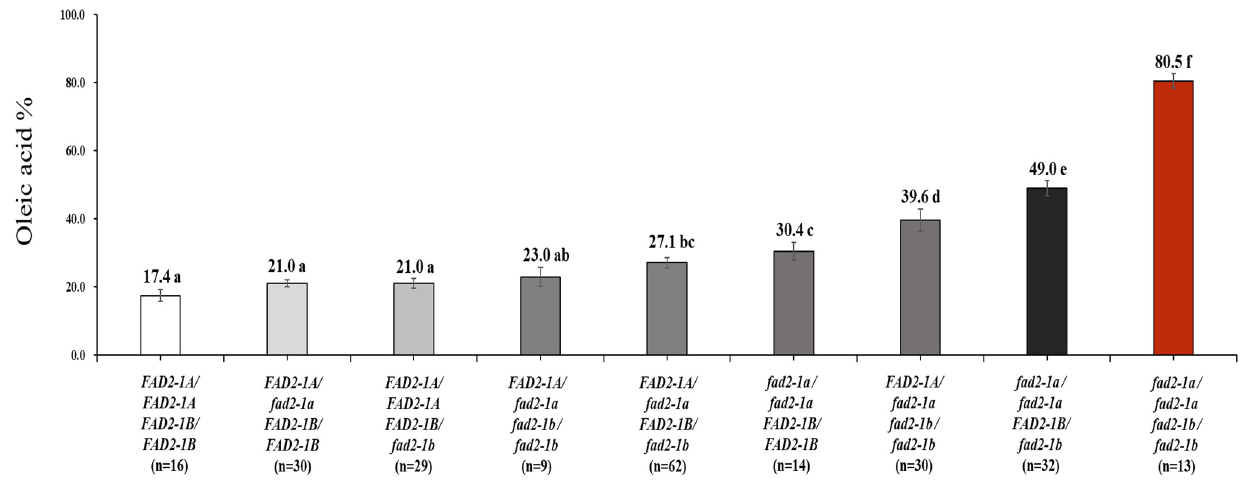
8 of 13 Figure 2. Distribution of oleic acid content from two segregating populations. ( a ) 100 F 2 seeds from a cross of PE529 and Pungsannamul showed altered oleic acid based on its genotype of FAD2-1A gene. ( b ) 100 F 2 seeds from a cross of PE529 and Sunpung showed altered oleic acid based on its genotype of FAD2-1A gene. The letters above the bars are statistically different based on least square difference. The FAD2-1A indicates functional microsomal delta-12 fatty acid desaturase 2 gene which is similar to the Williams 82 reference sequence for Glyma.10G278000 . The fad2-1a indicates mutant allele of FAD2-1A W293STOP in PE529. 3.4. Production of 80% Oleic Acid Concentration with a FAD2-1A W293STOP Allele in PE529 The F 2 progenies were obtained from population three, where FAD2-1A W293STOP and FAD2-1B P137R alleles were segregated (Figure 3). Results showed that 250 individ- uals belonging to nine different genotypic groups were found, as demonstrated by the combination of the FAD2-1A and FAD2-1B alleles. Progeny lines with functional alleles of FAD2-1A and FAD2-1B genes produced the lowest oleic acid concentration (17.4%), re- sulting in transgressive segregation. In contrast, individuals with fad2-1a W293STOP and fad2-1b P137R alleles had an average of 80.5% oleic acid concentration, which was signifi- cantly higher than those of other genotypic groups (Figure 3). The oleic acid concentration ranged from 72.0–84.1% in individuals with a combination of fad2-1a W293STOP and fad2- 1b P137R alleles. The F 2 progenies, where FAD2-1A W293STOP, FAD2-1A S117N, and FAD2-1B P137R alleles were segregated, were obtained from population four (Figure 4). In population four, the soybean cultivar Hosim produced approximately 80% of oleic acid concentra- tion, which also contained both mutant alleles of FAD2-1A S117N from 17D and FAD2-1B P137R from PI 283327. Based on the 288 F 2 seeds determined for their fatty acid profiles, 78 produced more than 70.0% oleic acid concentration and were genotyped with molecu- lar markers for FAD2-1A S117N, FAD2-1A W293STOP, and FAD2-1B P137R mutant alleles (Figure 4). A total of 78 F 2 progeny lines also had a homozygous mutant allele of the FAD2- 1B gene (P137R), which were segregated with FAD2-1A S117N and FAD2-1A W293STOP alleles. The oleic acid concentration of the F 2 progeny ranged from 71.8–79.9% for homo-